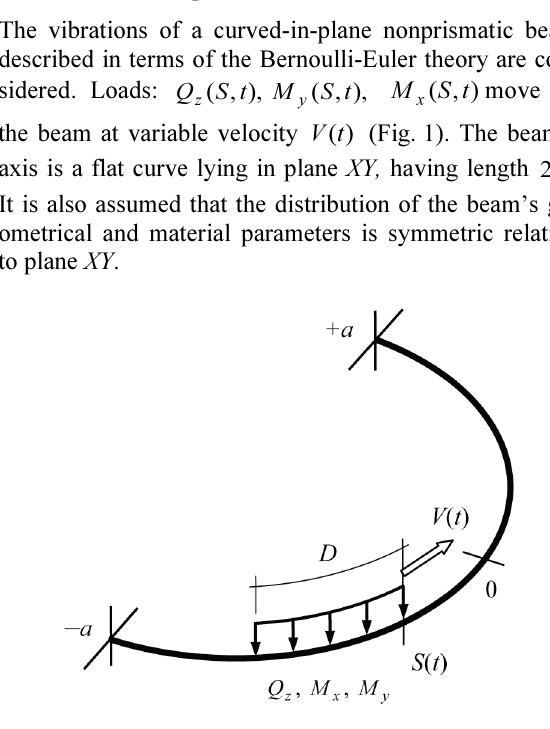
Fig. 1. Scheme of the